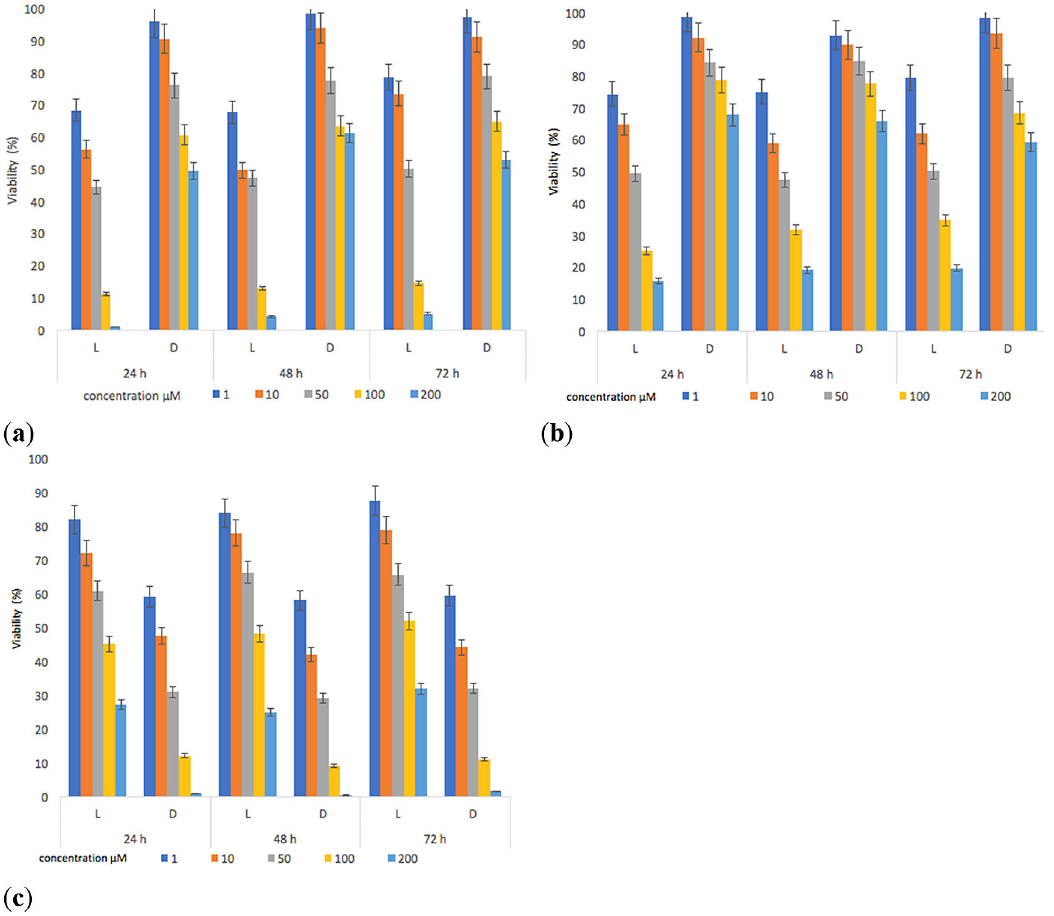
Figure 8. Parasite viability percentage results for L. panamensis against: (a) compounds ( 1 ), (b) compounds ( 2 ) and (c) positive control drug with incubation periods of 24, 48 and 72 hours.